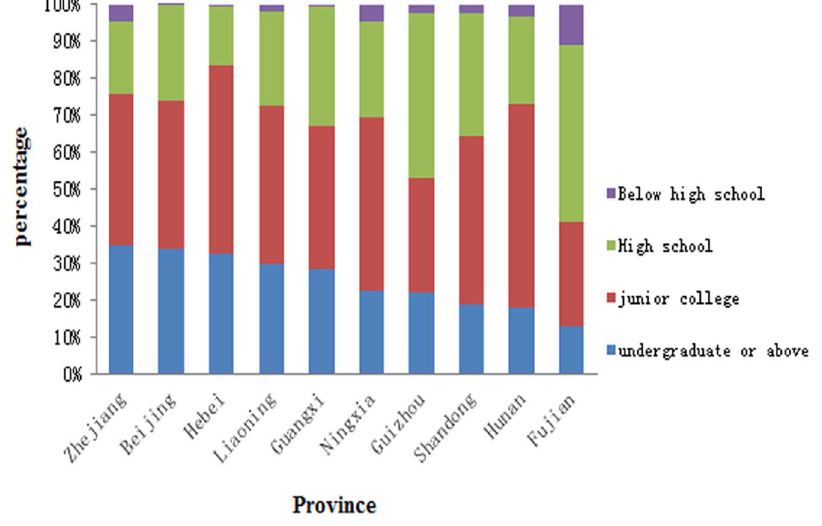
Fig. 4. Distribution of total health workers by education level in each province (n 5